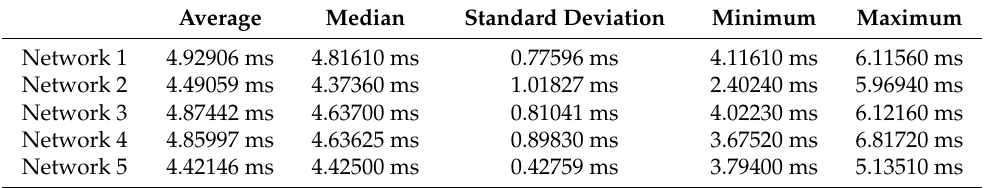
Table 5. Comparison between runtimes of each network for software-implemented networks.